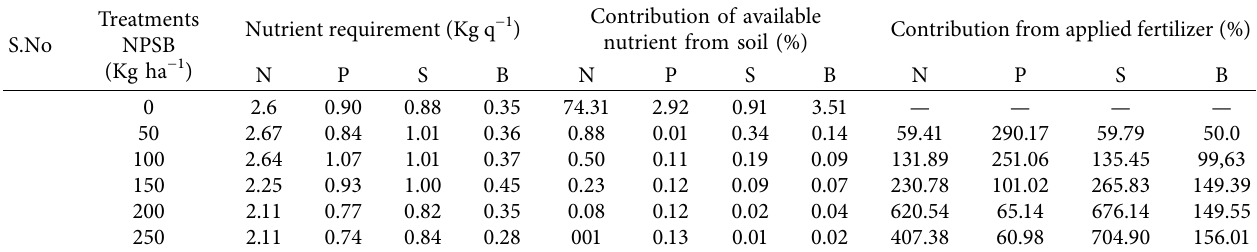
Table 5: Basic data for computing fertilizer dose for targeted yields of Nasir common bean variety at Meskan District, Gurage zone, Southern Ethiopia. S.No